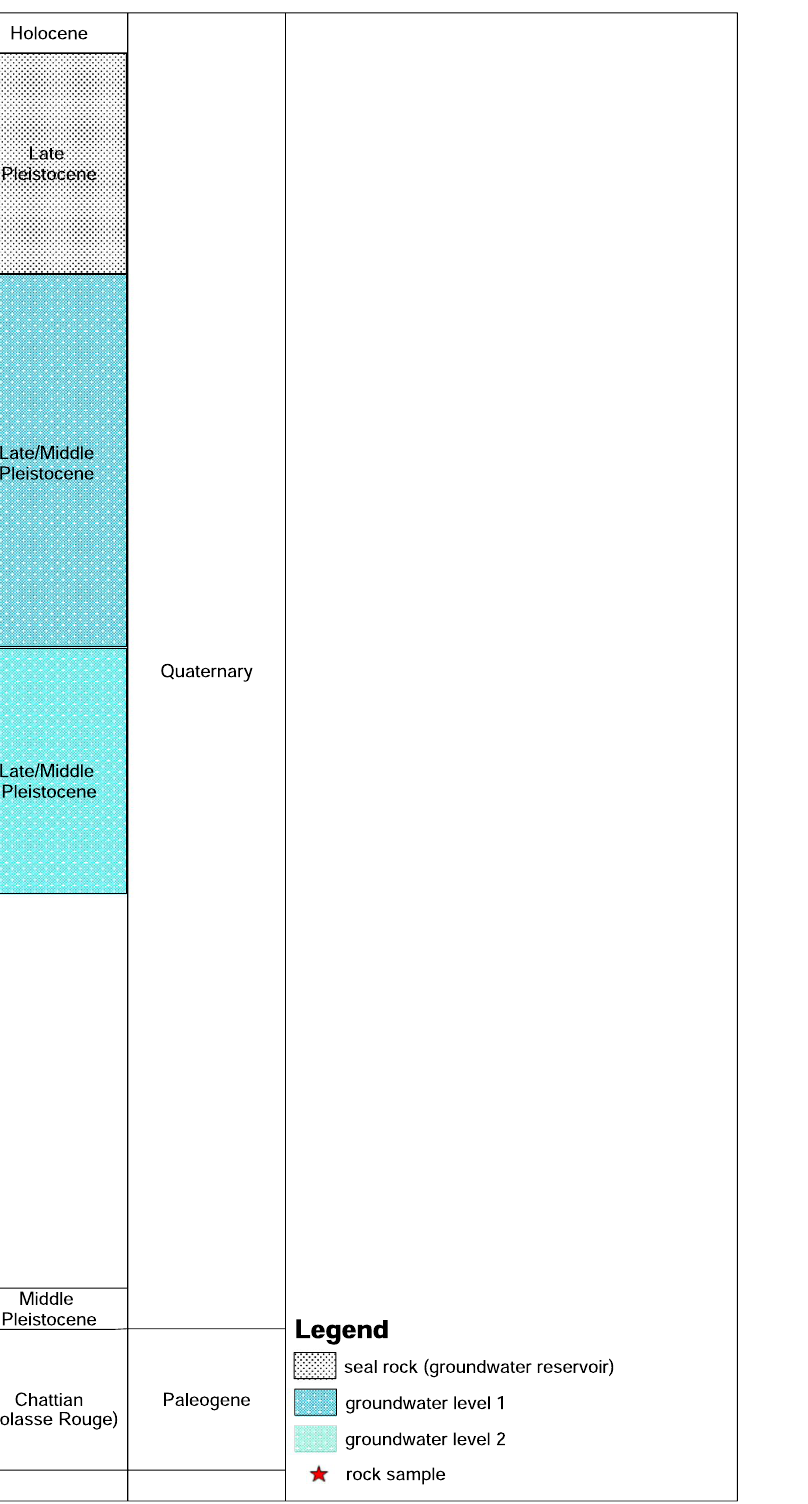
Fig. 17 Well Montfleury-2 located in an anticline structure, showing Pleistocene deposits confined within a topographic valley. Respective rock samples are shown in Fig.